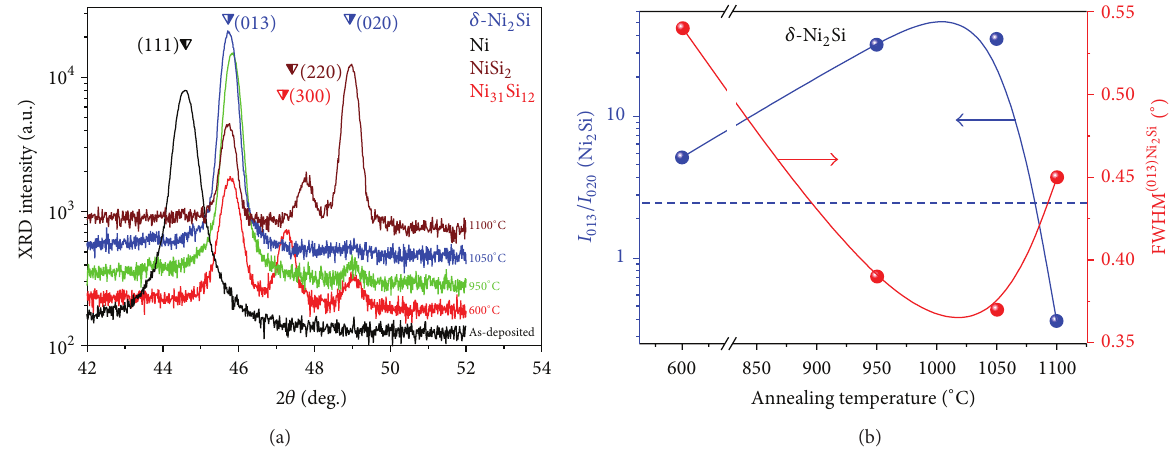
Figure 5: (a) XRD patterns of Ni 2 Si/ n -SiC contacts before and after annealing at 600, 950, 1050, and 1100 ∘ C. (b) Ni 2 Si texture ( 𝐼 013 /𝐼 020 ) and FWHM of (013)Ni 2 Si peak in XRD patterns versus annealing temperature (horizontal dash lines show the theoretical value for 𝐼 013 /𝐼 020 in the absence of texture) [66].